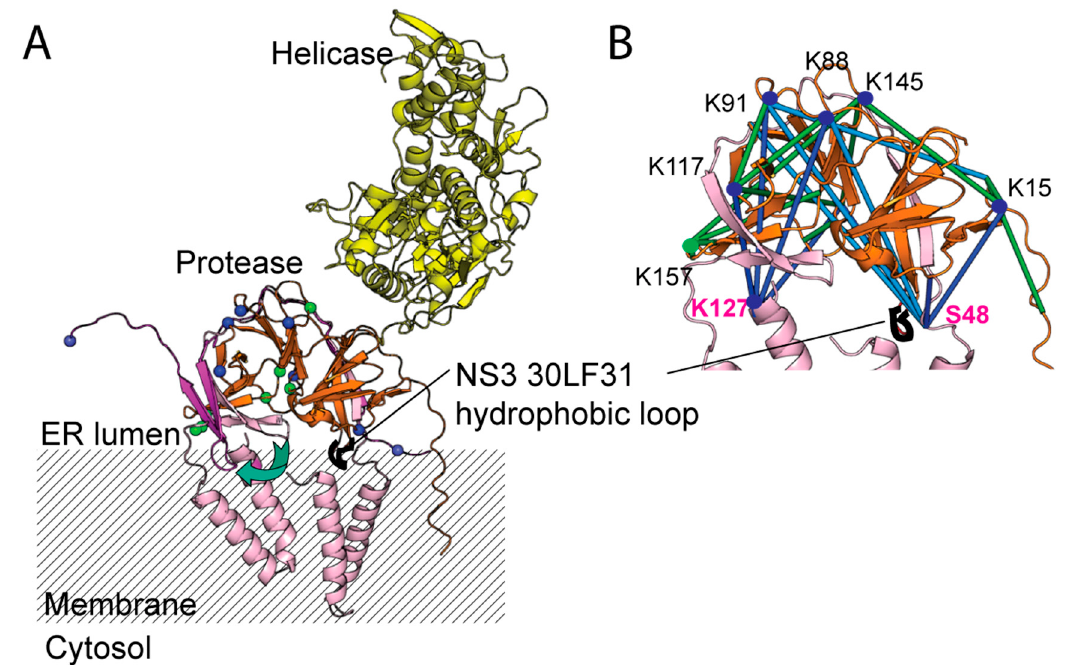
Figure 6. Model of full length DENV4 NS2B and NS3 on ER membrane. ( A ) eNS2B 47 NS3Pro structure is superimposed on full length DENV4 NS2B-NS3 predicted by AlphaFold. The NS3 helicase is coloured in yellow and protease in orange, the predicted NS2B full length is in light pink while the NS2B cofactor from eNS2B 47 NS3Pro structure is in magenta. The residues involved in intra-molecular cross-links are in green and the inter-molecular cross-linked residues are in blue. The hydrophobic loop of NS3 ( 29 GLFG 32 ) is shown in red. ( B ) The NS2B-NS3 protease is zoomed and the inter- and intra-molecular crosslinks are modelled on the NS2B-NS3 protease domain from AlphaFold model. The inter-molecular cross-links are in green and intra-molecular cross-links are in dark blue. The inter-molecular cross-links with C α -C α distance larger than 30Å are depicted as light blue.